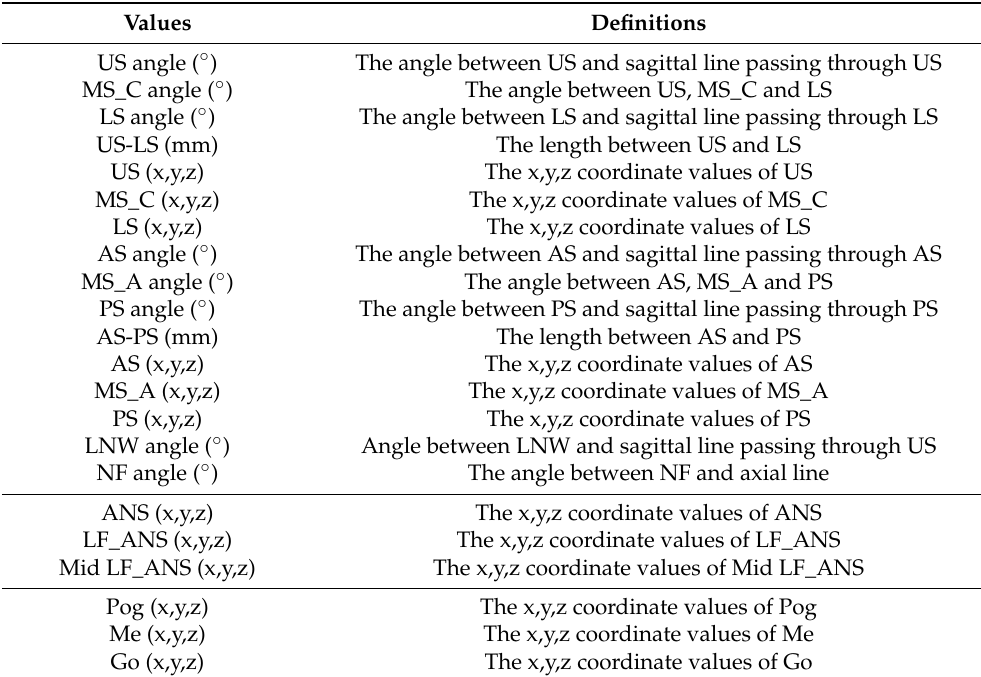
Table 2. Definitions of 3-dimensional